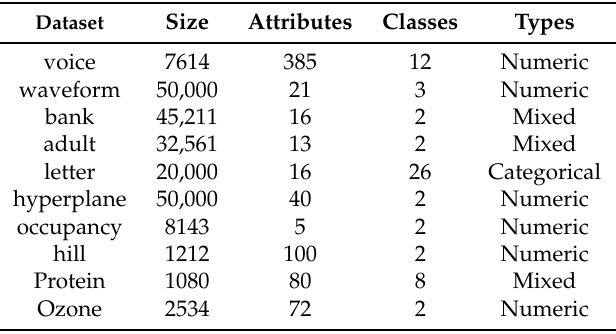
Table 1. The information of the experimental datasets.